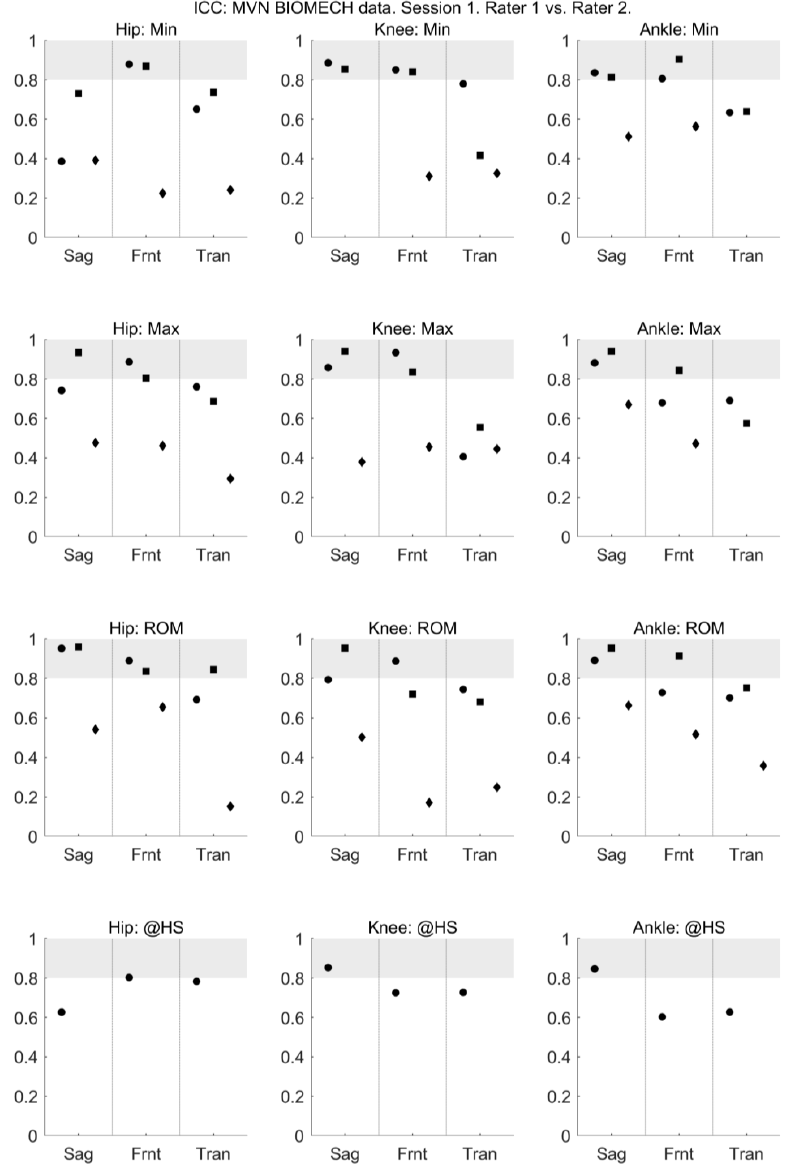
Figure 3. Between-rater intraclass correlation coefficient of MVN data collected by rater 1 (musculoskeletal physiotherapist) and rater 2 (clinical movement scientist) in session 1. Intraclass correlation coefficient is shown for the minimum angle (min; top row ), maximum angle (max; second row ), range of motion (ROM; third row ) and angle at heel strike (@HS; bottom row ) for the hip (left-most column), knee (centre column) and ankle (right-most column) joints in the sagittal (Sag), frontal (Frnt) and transverse (Tran) planes of movement. The three data points in each plane correspond to the walk (left-most point; circle), squat (centre point; square) and jump (right-most point; diamond) tasks. Grey shading indicates values considered to indicate excellent reliability.